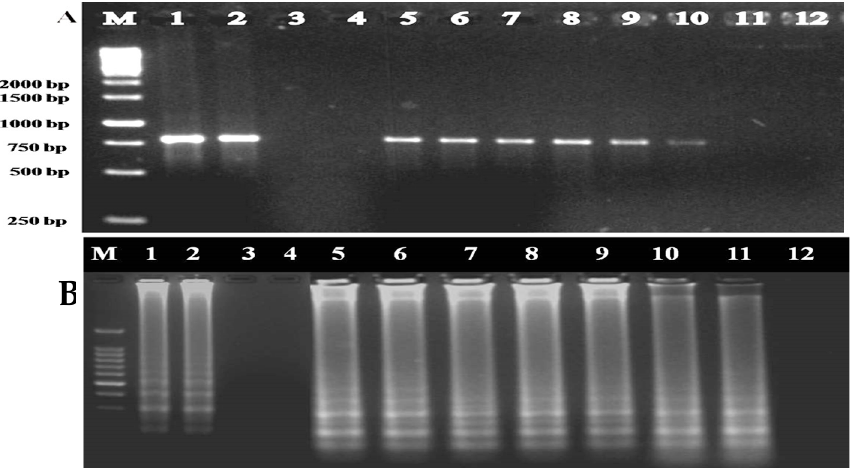
Figure 5. Comparative analysis of the sensitivity of IC-PCR and IC-LAMP using serial dilutions of